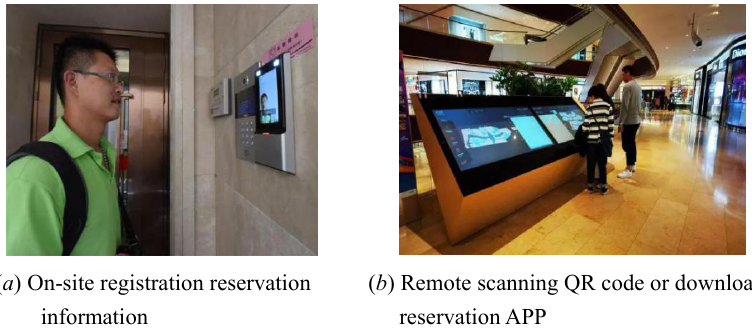
Figure 6. Two common ways for users to book